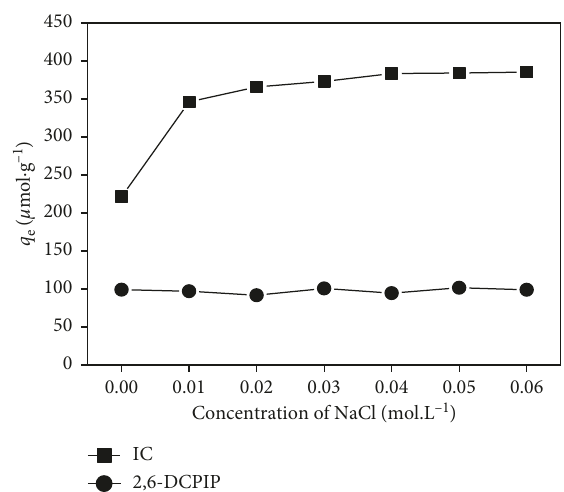
Figure 11: Effect of ionic strength on the IC and 2,6-DCPIP ad- sorption. Experimental conditions: [IC] � [2,6-DCPIP] � 5 × 10 − 5 mol · L − 1 ; m � 0.133g · L − 1 ; G � 0–100 μ m; t � 40min and pH � 6.2 for IC; t � 30min and pH � 6.7 for 2,6-DCPIP; v � 150rpm; V � 30mL; at room